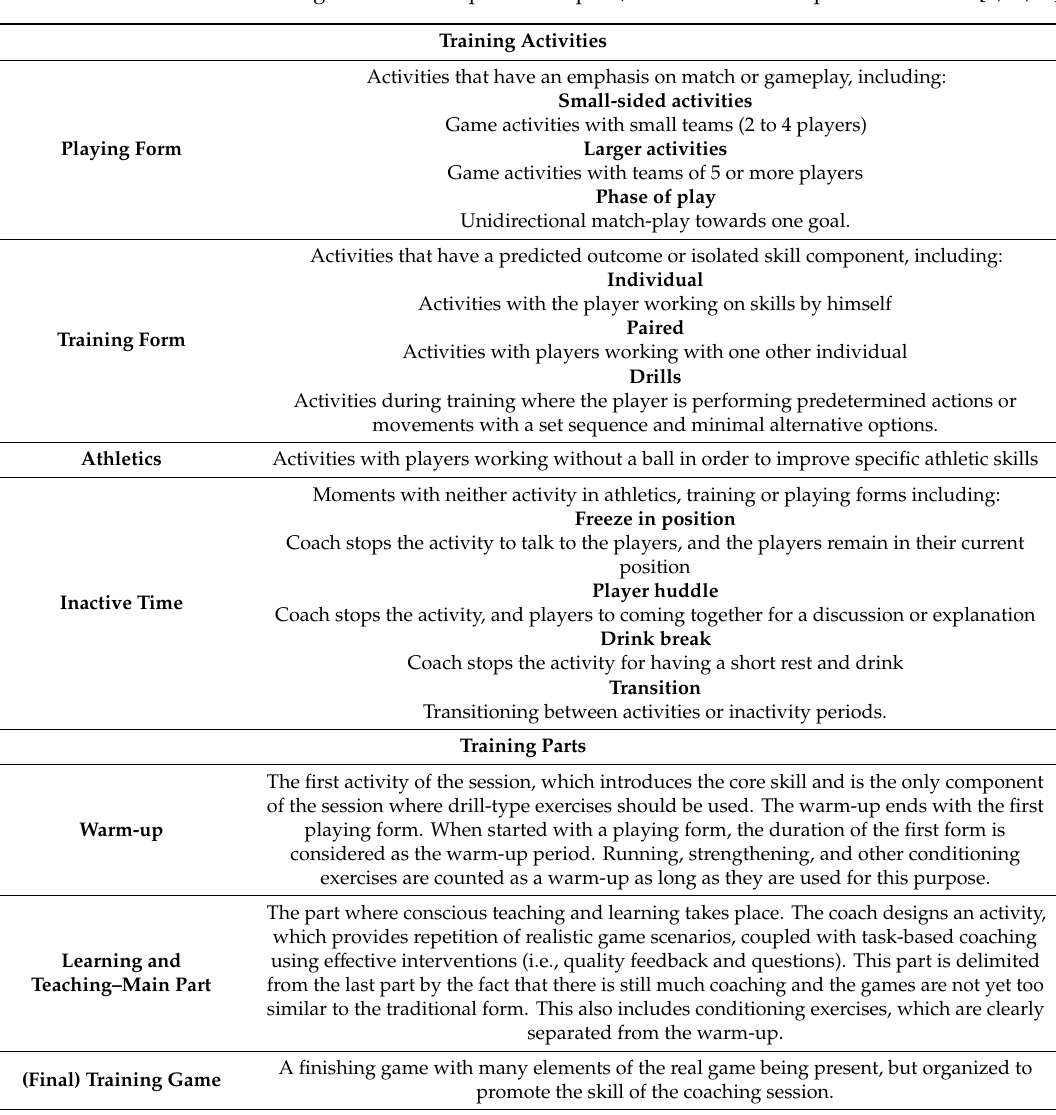
Table1. Definitions of training activities and parts. Adopted, modified and complemented from